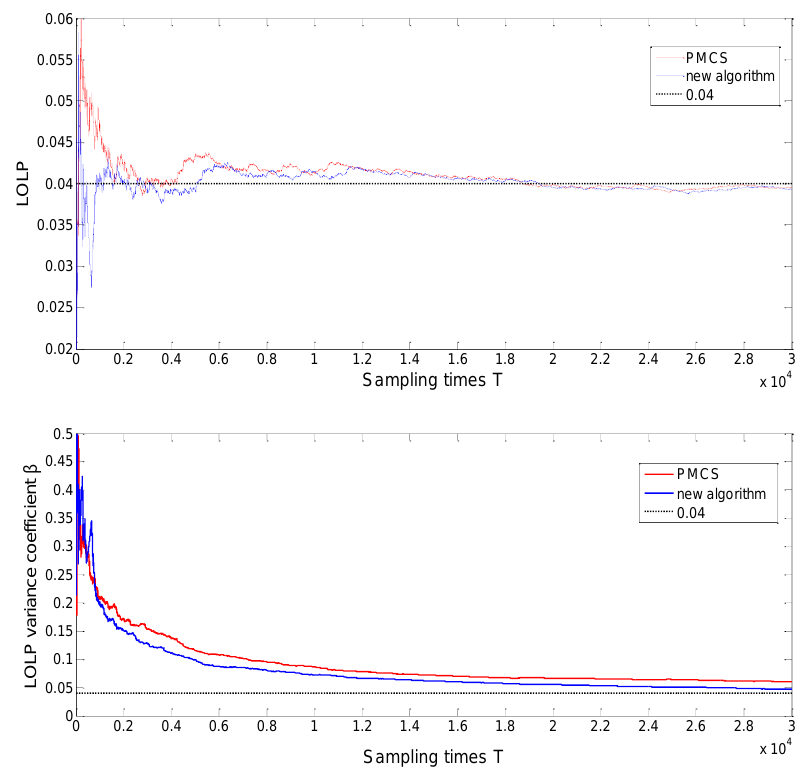
Figure 8. Convergence process of the Loss of Load Probability (LOLP) index in different algorithms.